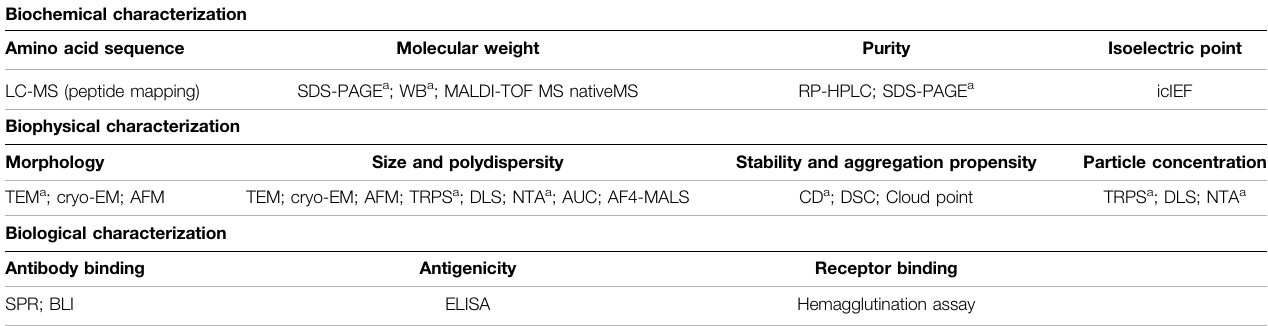
TABLE 1 | Bioanalytics for VLP characterization. Summary of analytical tools used for biochemical, biophysical and biological characterization of VLPs. Reviewed in Huang et al. (2017) and Nooraei et al. (2021). Biochemical